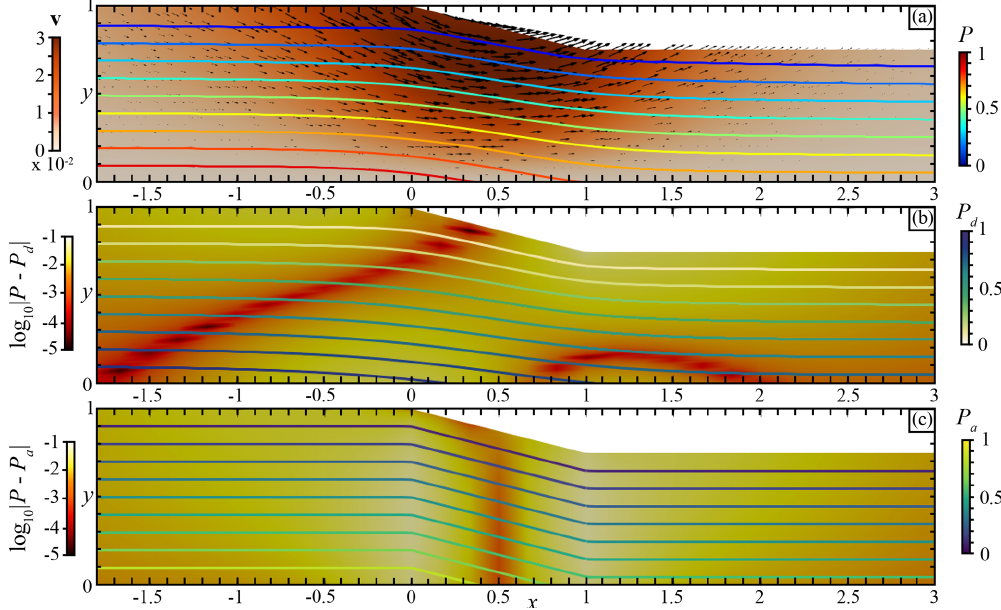
Figure 4. Non-dimensional “global” model for a large domain with a topographic perturbation. (a) The background colour shows the velocity field computed with the Eq. (3). The coloured curves show the total pressure P iso-values every 0.1 computed with Eq. (3). (b) Comparison between the total pressure from Eq. (3) and the pressure P d computed from Eq. (7). The coloured background shows the difference log 10 | P − P d | . The coloured curves show the pressure P d iso-values every 0.1 computed with Eq. (7). (c) Comparison between the total pressure from Eq. (3) and the pressure P a computed from Eq. (2). The coloured background shows the difference log 10 | P − P a | . The coloured curves show the pressure P a iso-values every 0.1 computed with Eq.